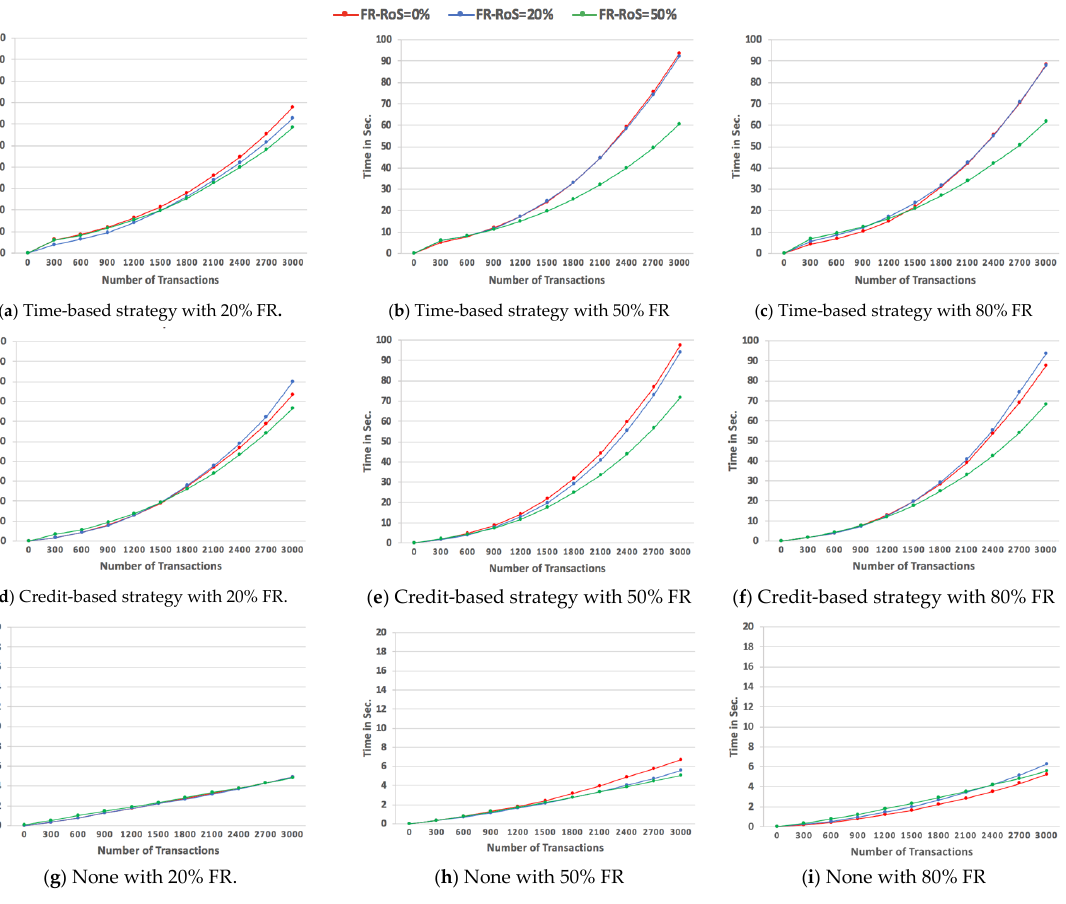
Figure 7. Execution Time of each strategy.